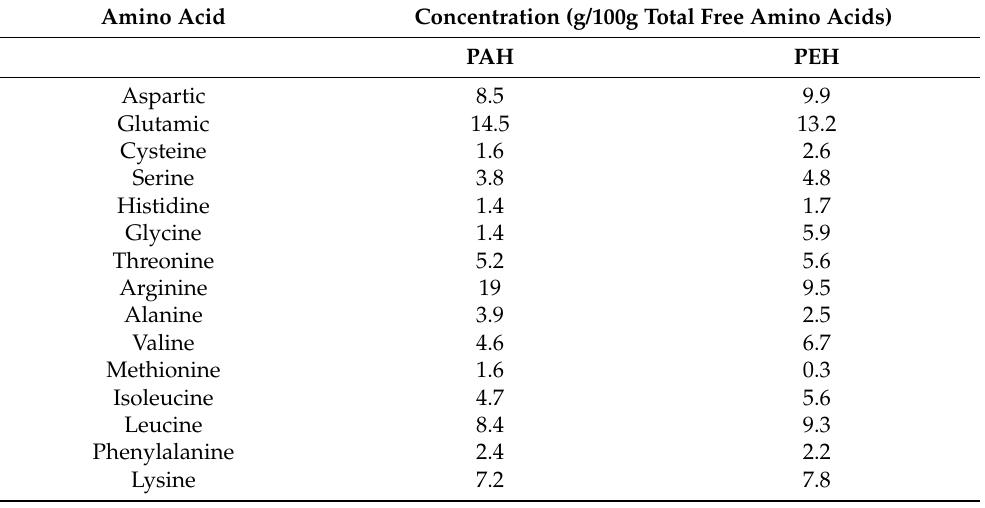
Table 2. Free amino acids (g/100g total free amino acids) of pepsin (PEH) and papain (PAH) whey protein hydrolysate. Amino